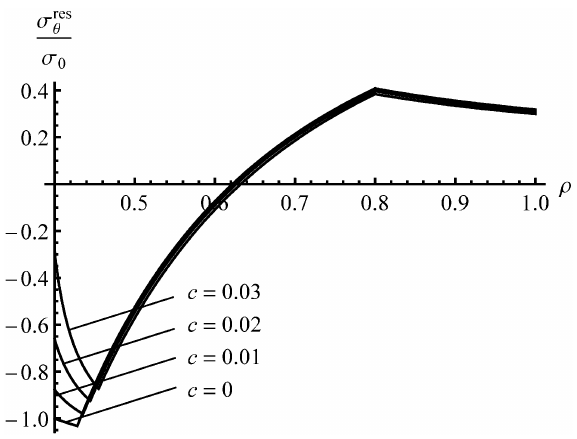
Figure 4. Distribution of the residual circumferential stress in an a = 0.4 cylinder.